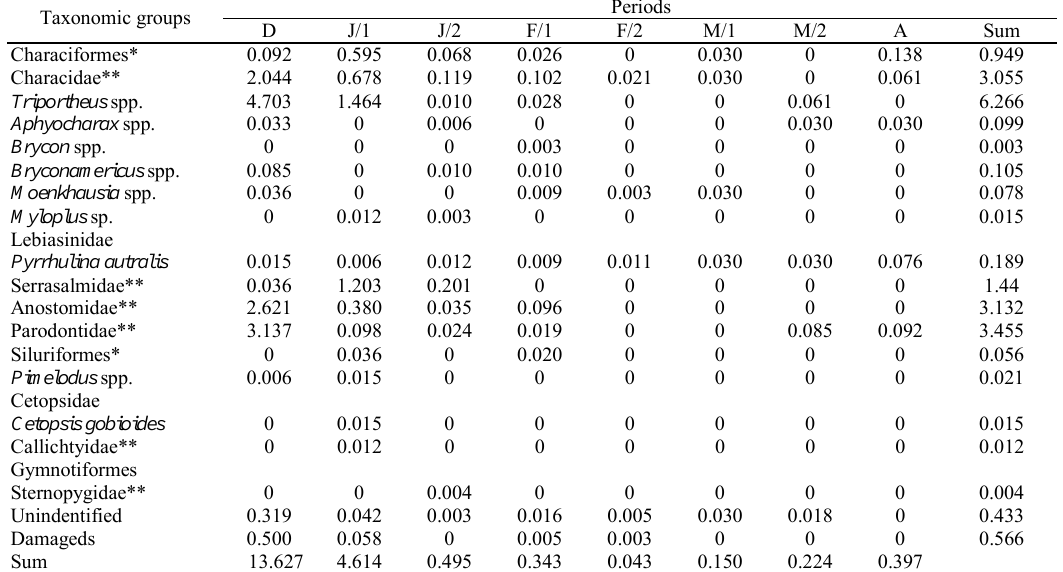
Table 1. Taxonomic groups and fish larvae densities (larval density/10m³) captured in the marginal lagoons along the Cuiabá River, Pantanal of Mato Grosso. *Larvae identified only at the order level; **Larvae identified only at the family